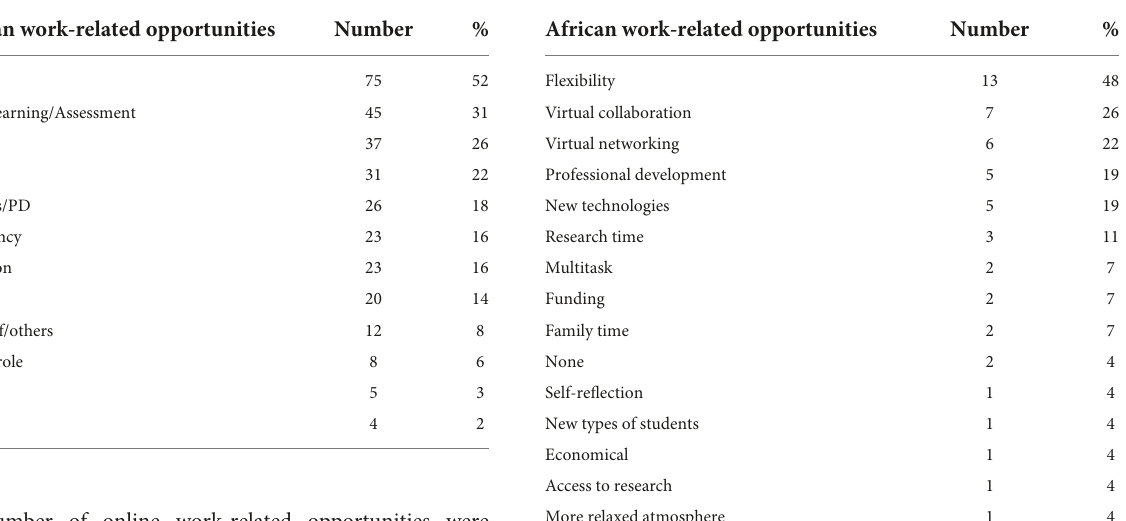
TABLE 5 Australian work-related opportunities. TABLE 6 African work-related